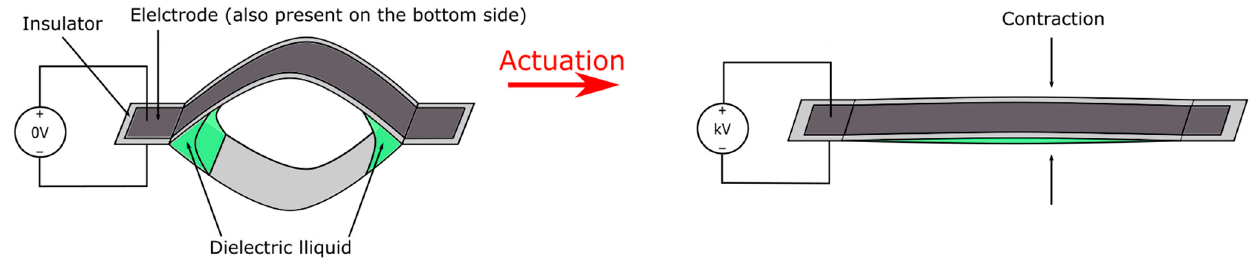
Figure 5. The actuation scheme of an electro-ribbon actuator. Upon applied voltage (in the kV) a non-uniform electric field (in the length direction) will be formed between the two electrodes with the strongest fields at the two hinges and the weakest field at the center, causing the two tiles to zip together from the two hinges.